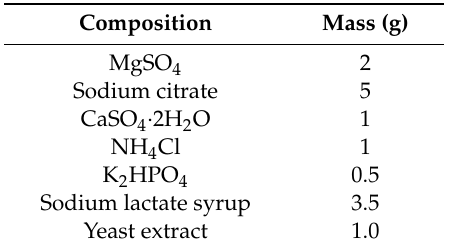
Table 2. The chemical composition of the